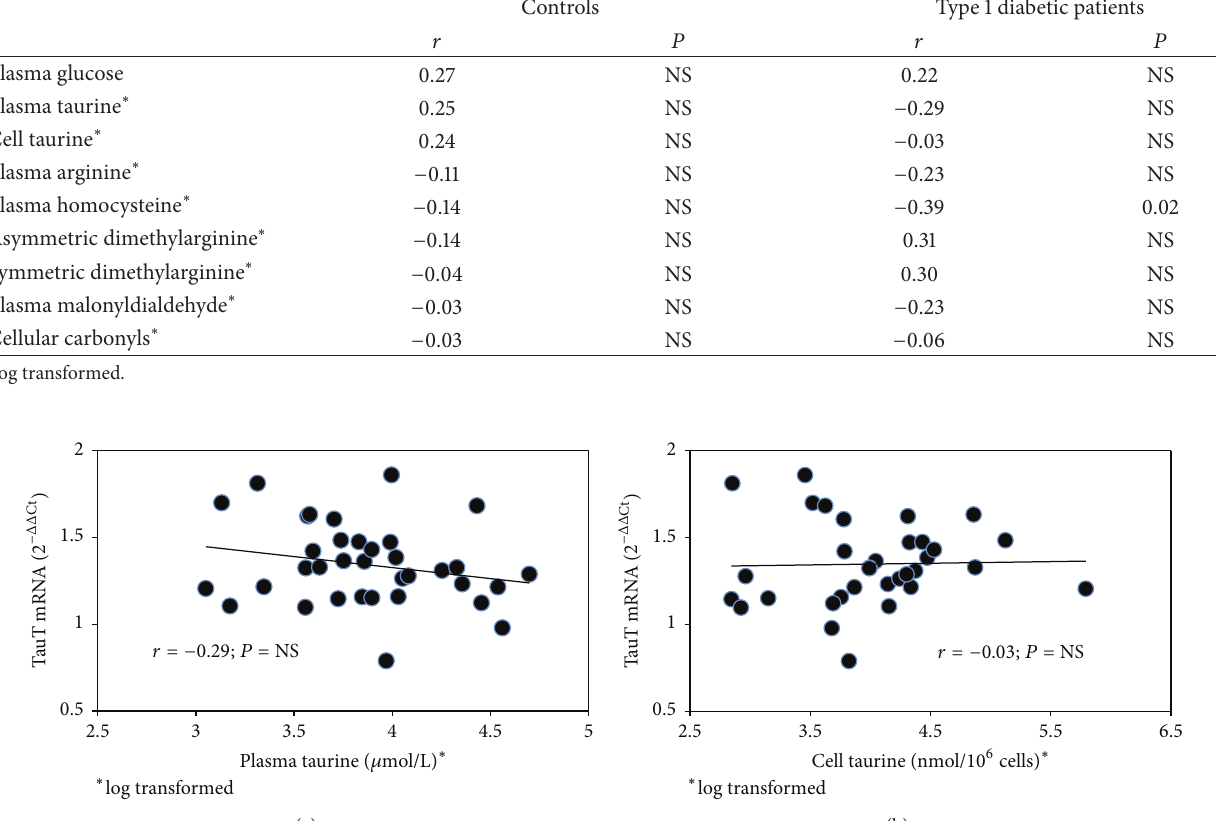
vivo” seem to be quite different from the findings obtained in experimental models “in vitro” where acute exposure to hyperglycemia and oxidative stress downregulate TauT mRNA gene expression in some cellular types